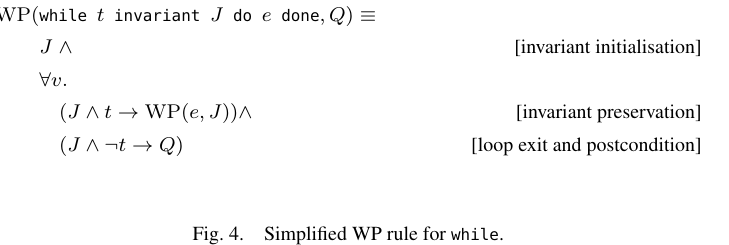
Fig. 4. Simplified WP rule for while